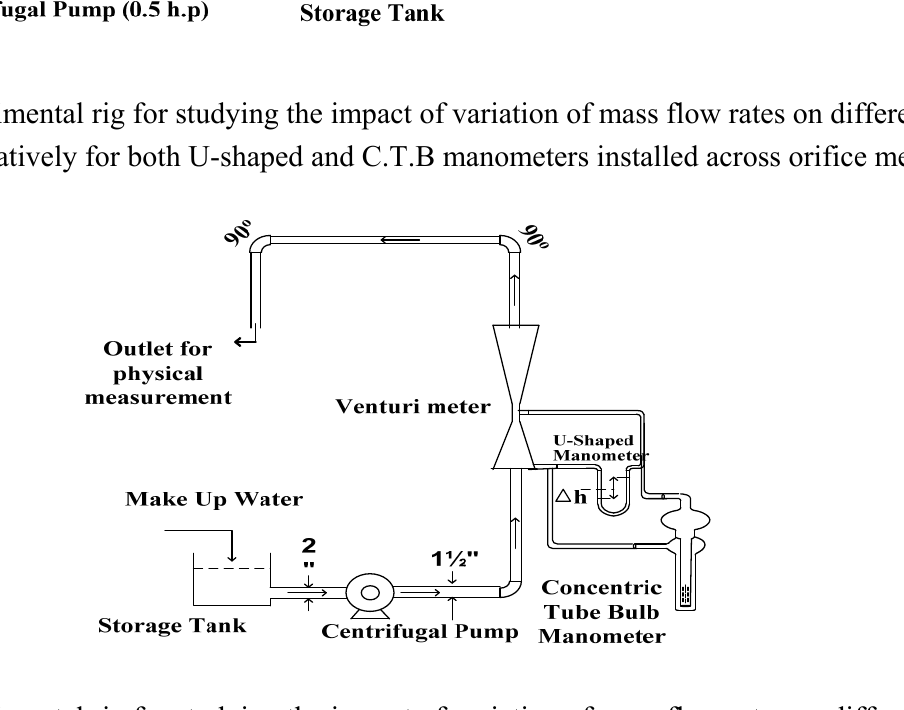
Figure 3. Experimental rig for studying the impact of variation of mass flow rates on difference in heights alternatively for both U-shaped and C.T.B manometers installed across venturimeter.